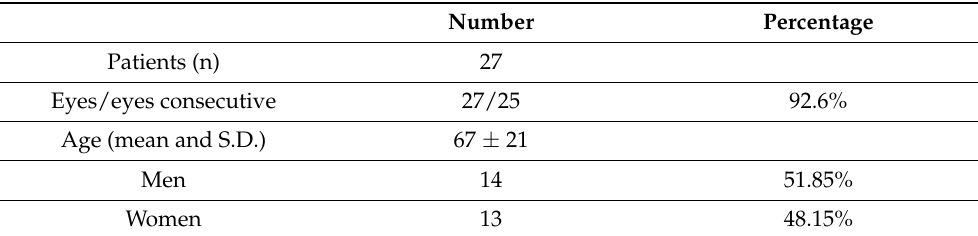
Table 1. Demographics for patients who underwent DMEK “Wave